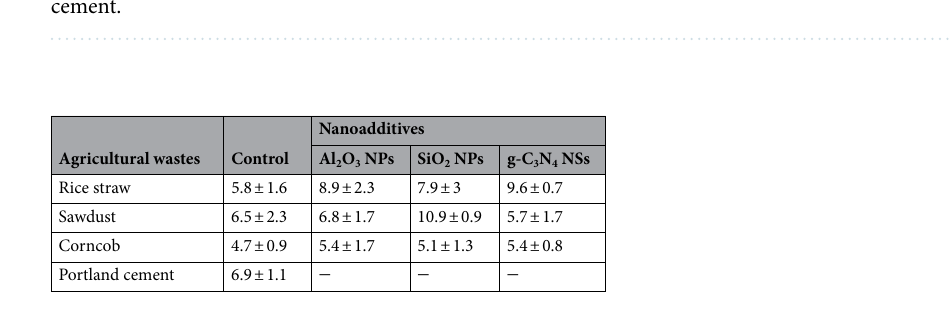
Table 5. Results of the Water Absorption Test (%) of different nano additives to agricultural waste’ bio-